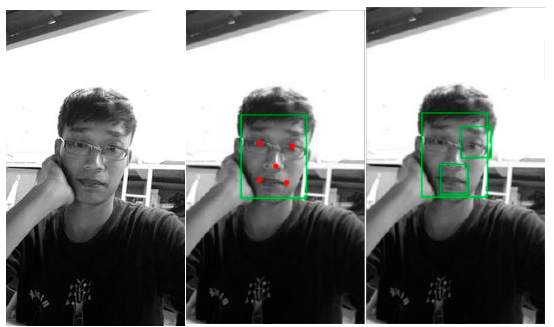
Figure 5. Multi-task cascaded convolutional neural network (MTCNN) detects face and key points.